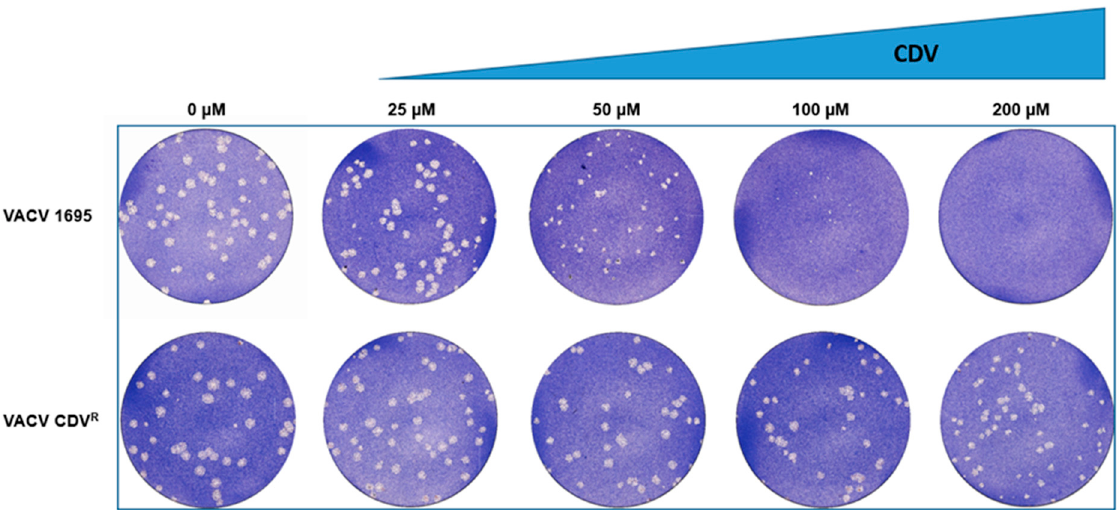
Figure 3. Generation of cidofovir-resistant VACV. VACV 1695 and VACV CDV R (carrying both A314T and A684V mutations) were tested for plaque formation on Vero cell monolayers overlaid with medium containing increasing concentrations of CDV. Three days post-infection, cells were fixed and stained with 0.1% crystal violet. Photographs of the crystal-violet-stained cell monolayers are shown.